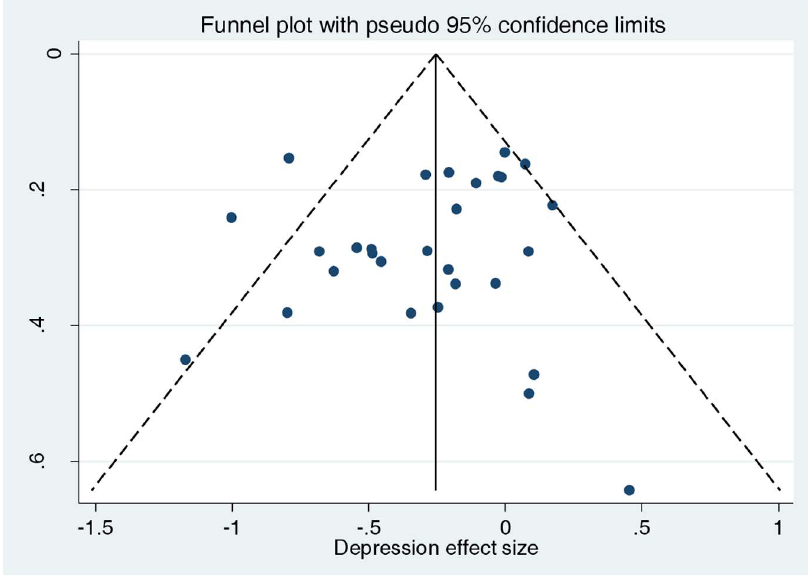
Figure 4. Funnel plot of effect size versus standard error for depression outcomes.